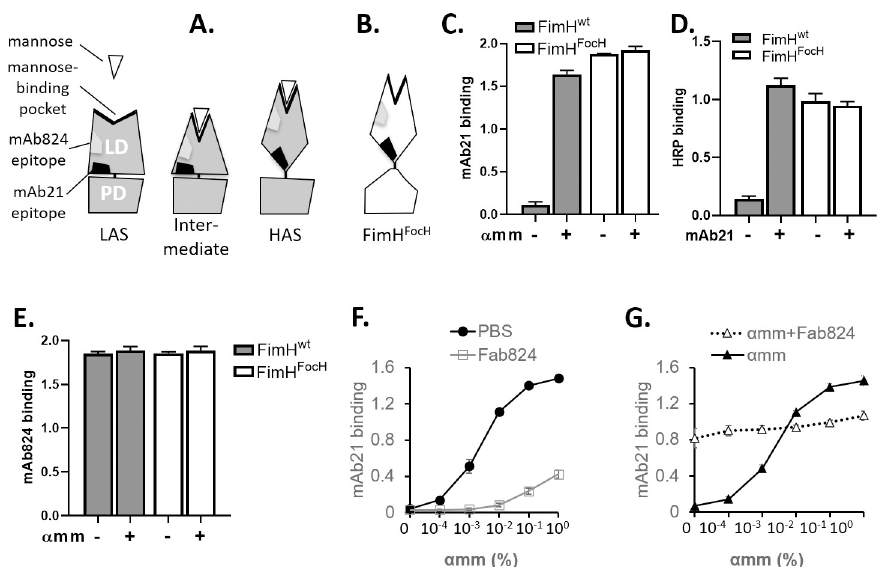
Fig 1. Recognition of FimH variants by mAb21 and mAb824. Cartoon representation of LAS, intermediate and HAS conformations (A) and FimH FocH mutant variant (B) of FimH adhesin. The putative locations of mAb21 and mAb824 epitopes are indicated as black and grey shapes, respectively. (C) Binding of mAb21 in the absence or presence of 1% α mm to plate-coated fimbriae carrying different variants of FimH adhesin. (D) HRP binding to plate-coated fimbriae in the absence of mAb21 and upon forming a complex with mAb21 in the presence of mannose; mean ± SD, n = 1. (E) Binding of mAb824 in the absence or presence of 1% α mm to plate-coated fimbriae carrying different variants of FimH adhesin. (F-G) Binding of mAb21 to plate-coated FimH wt fimbriae in the presence of different concentration of α mm; and upon no treatment (solid line with closed circle) or pre-treatment with α mm (solid line with closed triangle), Fab824 (solid gray line with open square), and Fab824 and α mm together (dashed line with open triangle), as designated in the figure Data (C and E-F) are mean absorbance values at 650 nm ± SEM, n = 3.